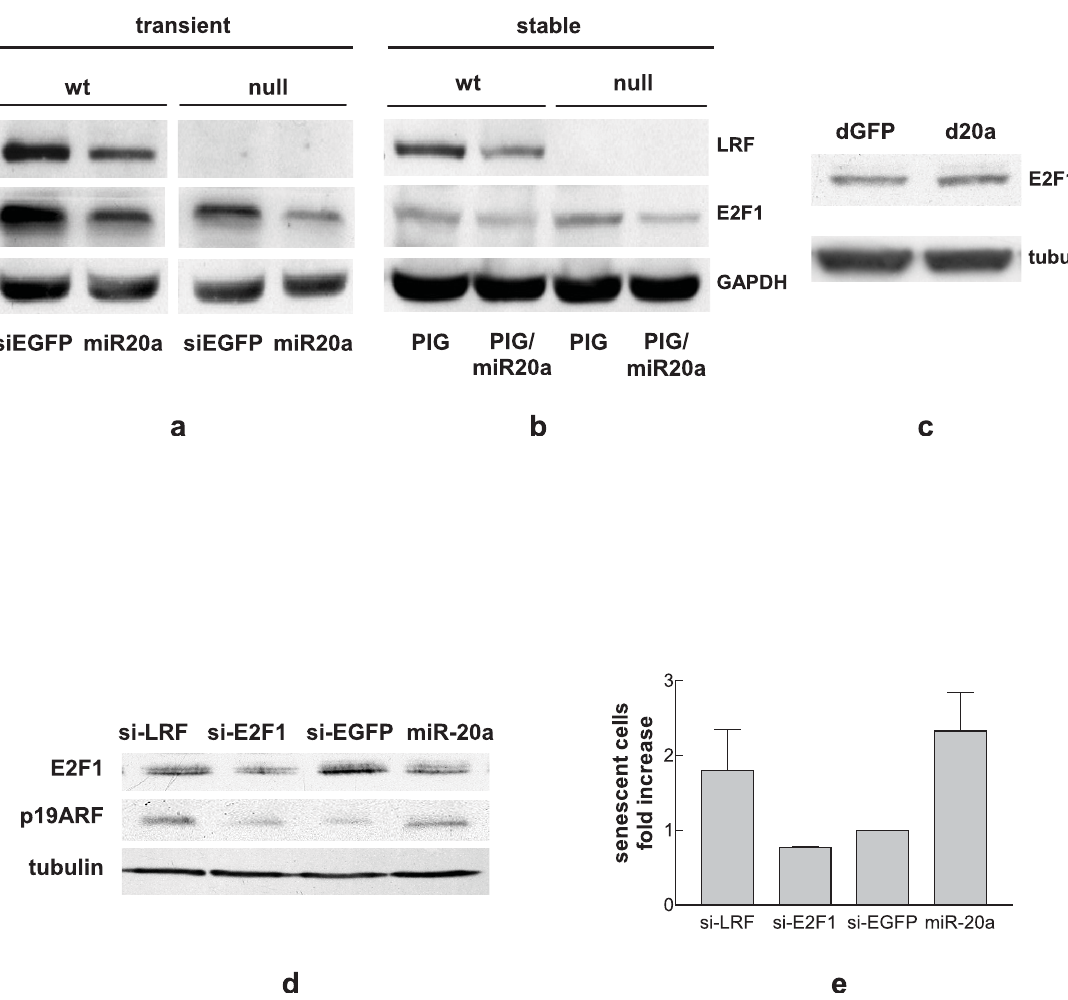
Figure 4. miR-20a regulates E2F1. Western blot analysis showing the expression of LRF and E2F1 in wt (a) and LRF-null MEF (b) retrovirally infected with PIG/miR-20a; c: Western blot analysis showing the expression of E2F1 in MEF transfected with d-20a; d: Western blot analysis showing the expression of E2F1 and p19ARF in wt MEF transfected with si-LRF, si-E2F1, si-EGFP and miR-20a; e: percentage of SA-ß-gal positive cells in wt MEF transfected with si-LRF, si-E2F1, si-EGFP and miR-20a.